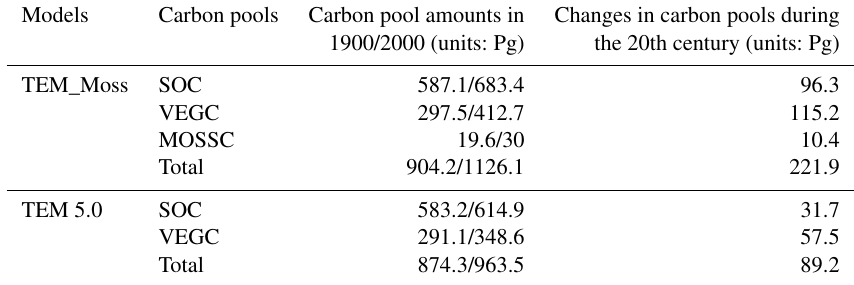
Table 10. Increase in SOC, vegetation carbon (VGC), and moss carbon (MOSSC) from 1900 to 2000 and total carbon storage during the 20th century predicted by two models. Models Carbon pools Carbon pool amounts in Changes in carbon pools during 1900/2000 (units: Pg) the 20th century (units: